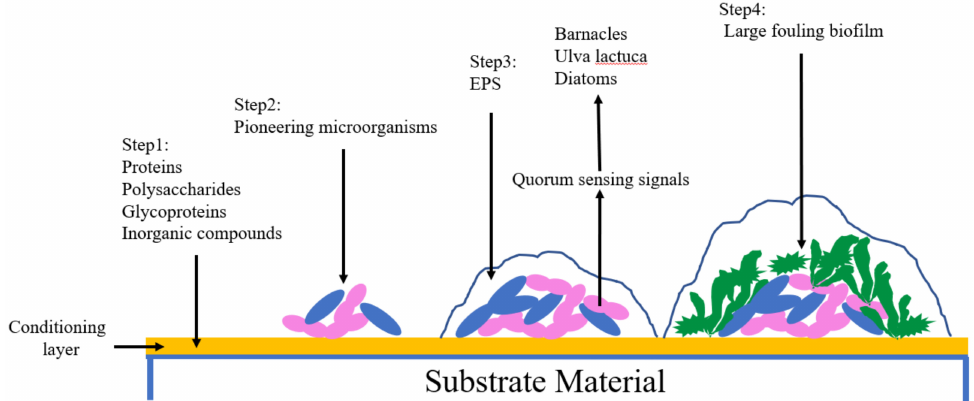
Figure 1. Primary steps in fouling organism’s attachment. EPS: extracellular polymeric